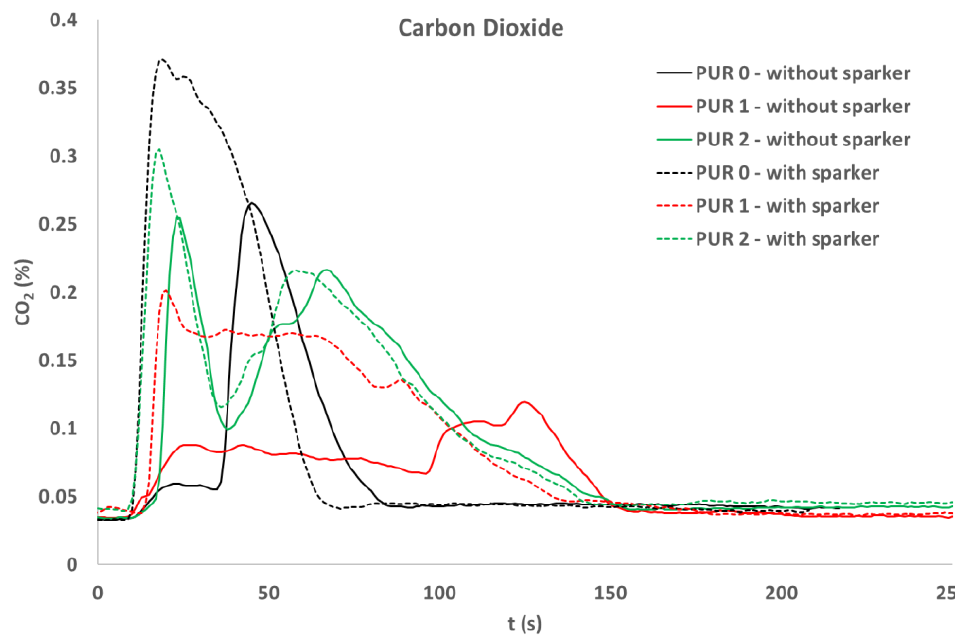
Figure 10. Carbon dioxide release, during exposure of the PURs to the 40 kW/m 2 of heat flux; self-ignited and ignited with a spark igniter.